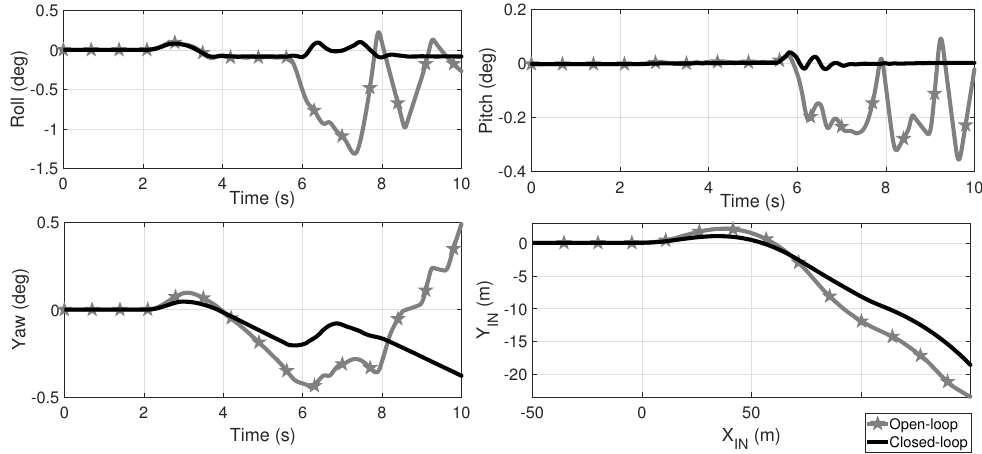
Figure 9. Comparative of the roll, pitch and yaw angles as well as the TWV displacement for open (black plots) and closed-loop (gray-star marked plots), and a friction coefficient µ = 0.45 for the maneuver of Figure 2a augmented by 300%. At the second 5.6, a speed bump is simulated by an exogenous road step (Figure 2b) in the front wheel and 0.1 seconds later in the rear right wheel. In open-loop, the vehicle suffers a rollover from second 6 as the roll angle indicates and in closed- loop the rollover is avoided; since the three wheels lose ground contact at second 5.8 oscillations are expected at the TWV landing. In the Supplementary Material Section, a link is provided with video animations.